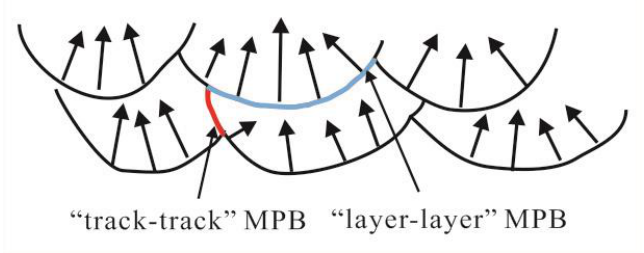
Figure 9. Schematic diagram of the crystallization solidification of molten pools during SLM process.